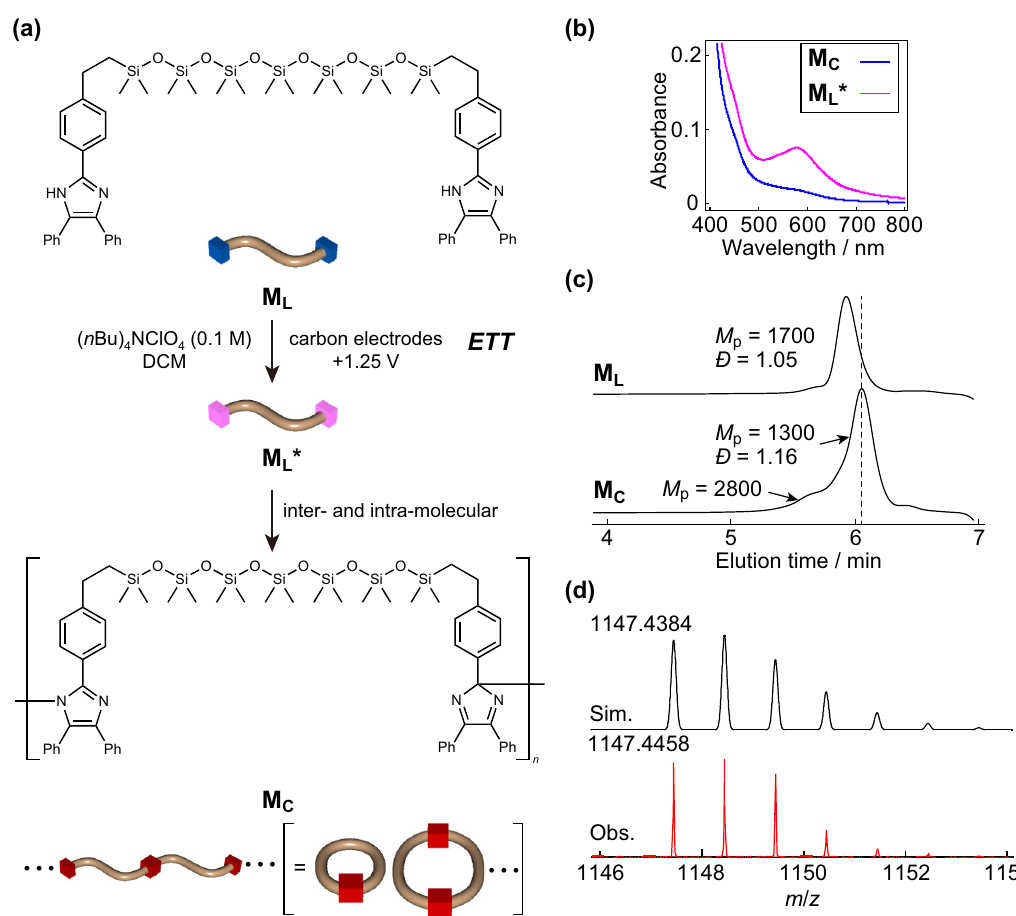
Fig. 3 Electrochemical oxidation of M L . a Synthesis of M C upon applying a potential of 1.25 V to DCM solution of M L containing ( n Bu) 4 NClO 4 with carbon electrodes. b UV – vis spectra of M C and M L * . c SEC traces of M L and M C . d Simulated and observed isotopic patterns of M C analyzed by positive mode ESI- HRMS